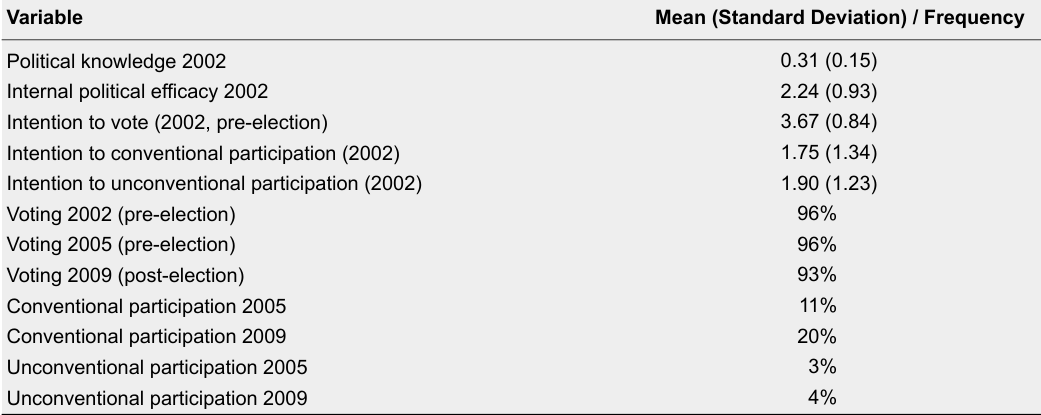
Means and Standard Deviations of the Independent, Mediator, and Dependent Variables